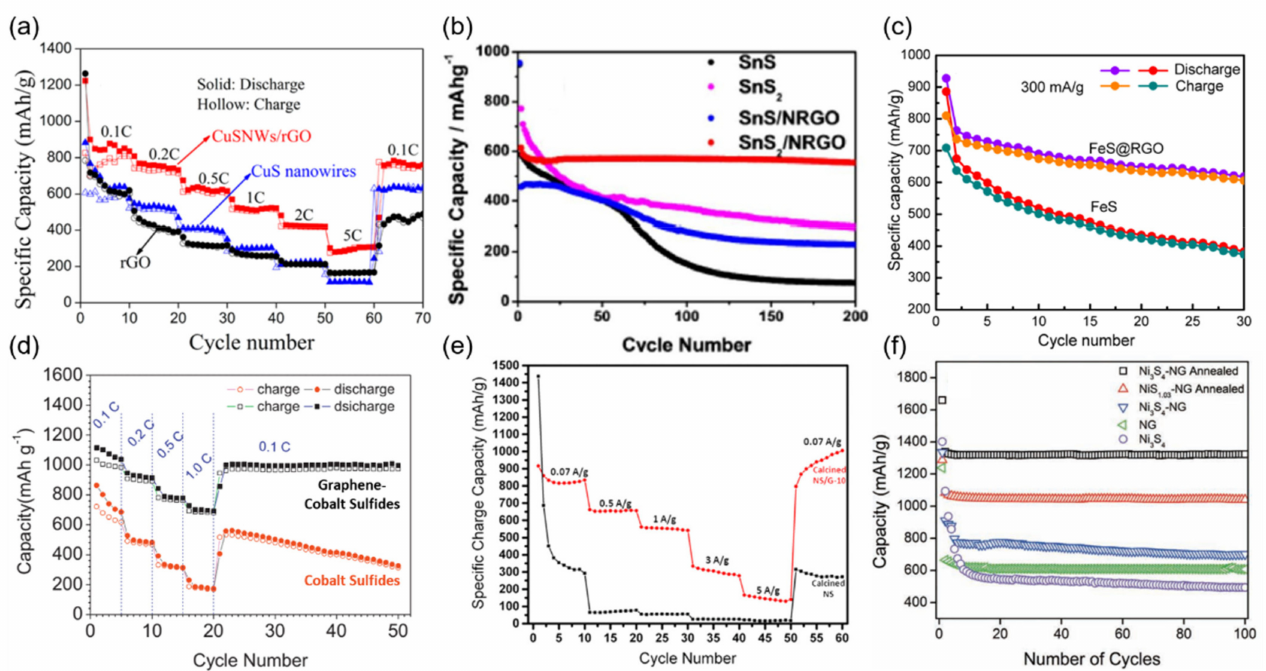
Figure 8. Cycle performance of graphene composite anode materials with ( a ) CuS, ( b ) SnS/SnS 2 , ( c ) FeS, ( d ) cobalt sulfides, ( e ) nickel sulfides, and ( f ) Ni 3 S 4 /NiS 1.03 . Reproduced with permission from ref. [83–86,88,89], respectively.